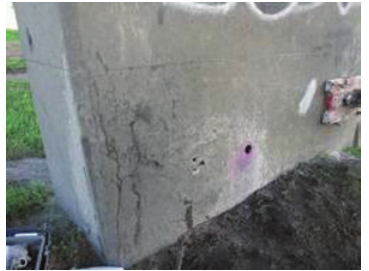
fig. 8. Reinforcement corrosion cracks at the pier corner